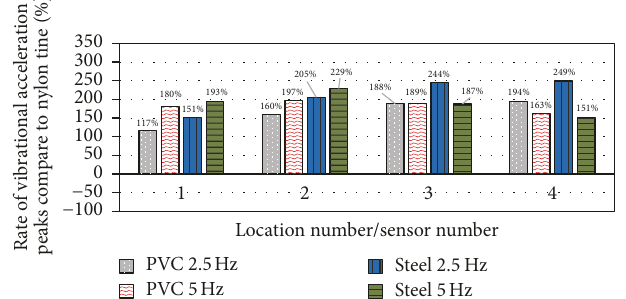
Figure 12: The rate of vibrational acceleration peaks exerted by straight PVC tine and straight steel tine compared to straight nylon tine for trial